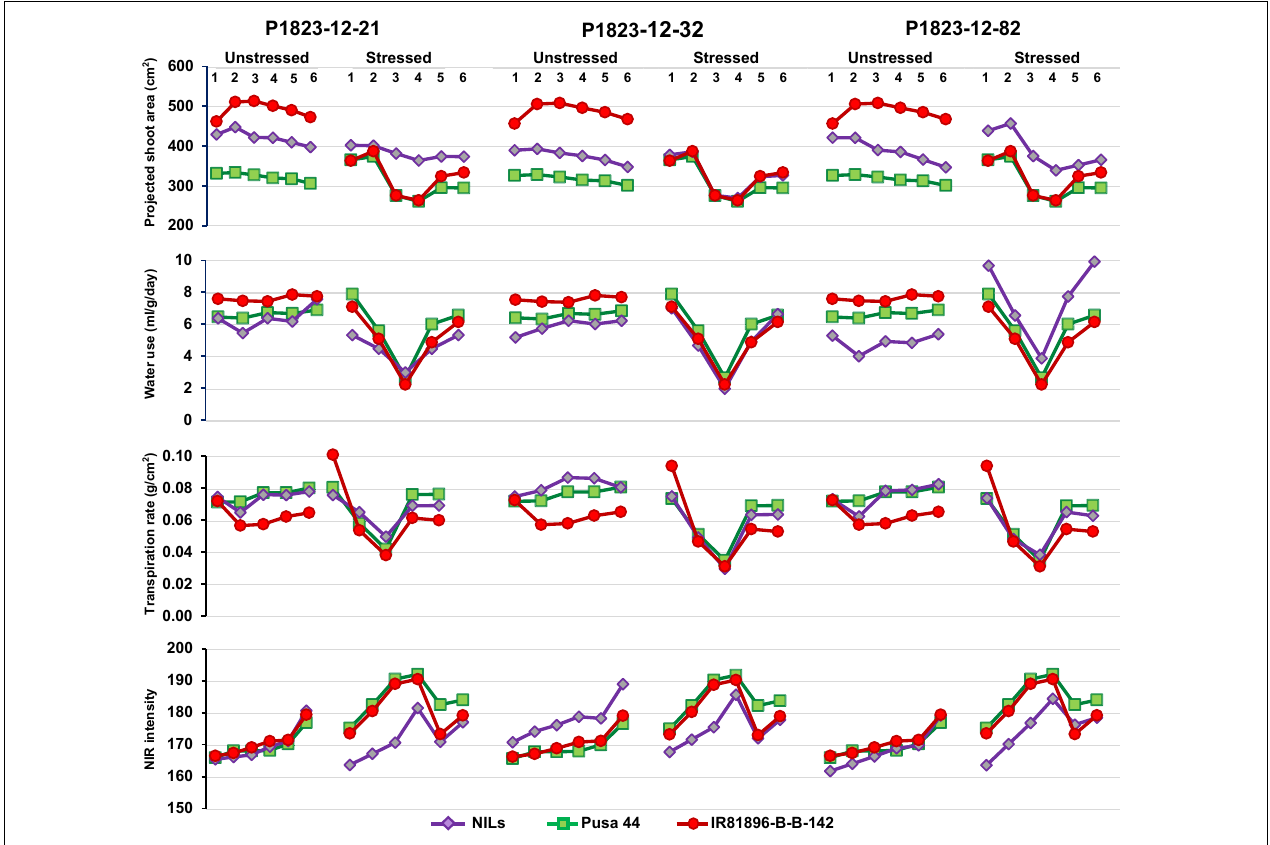
FIGURE 4 | Graphical trends of three variable near-isogenic lines (NILs) (P1823-12-21, P1823-12-32, and P1823-12-82) under control and stress conditions for phenomics parameters.